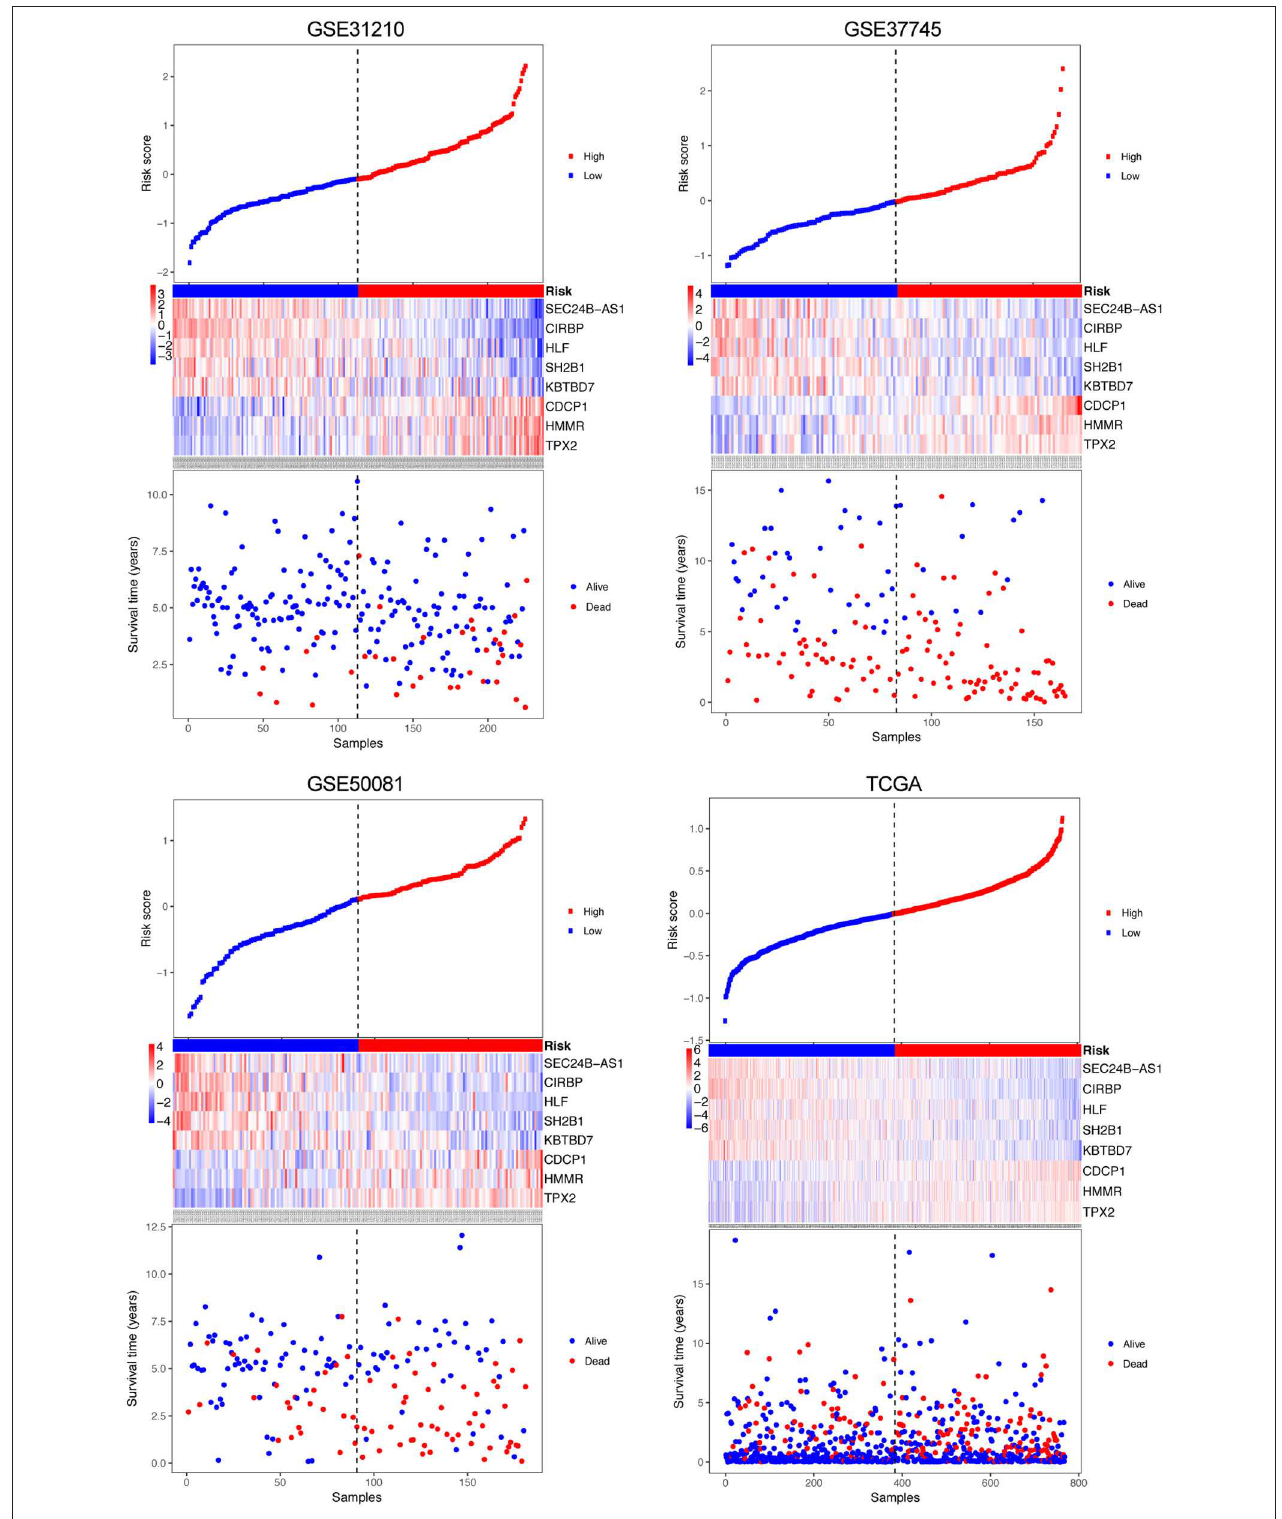
FIGURE 2 | Risk-score analysis of early-stage NSCLC patients in the four datasets. In each dataset, the risk score distribution, gene expression profiles, and patients’ survival status are displayed. The black-dotted line represents the median cut-off, dividing patients into high- and low-risk groups.